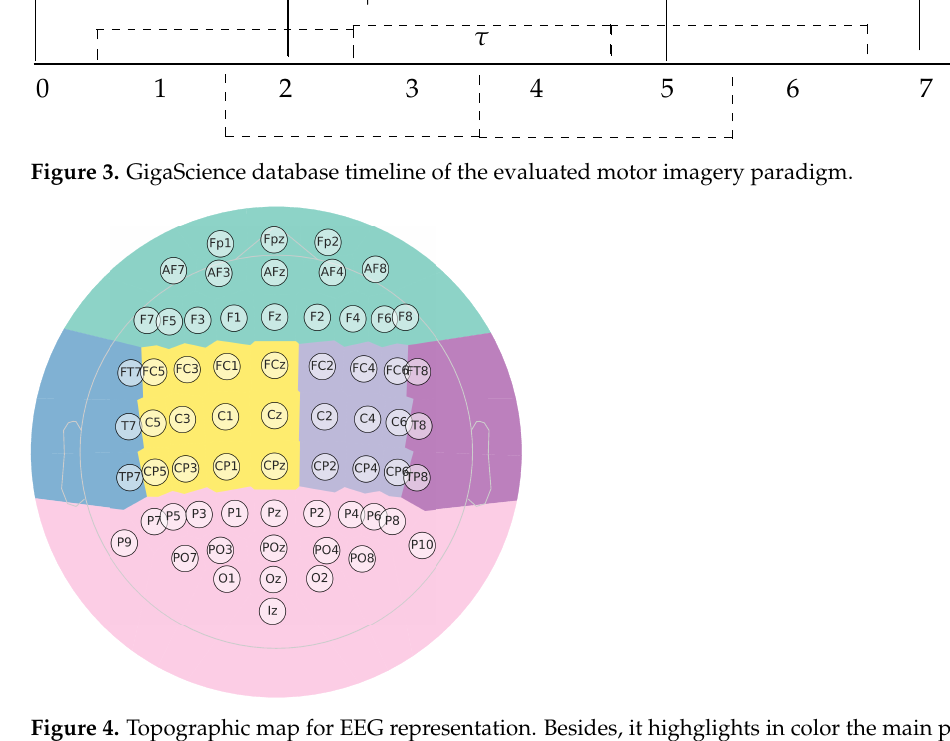
Figure 4. Topographic map for EEG representation. Besides, it highglights in color the main parts of the brain (Frontal, Central right, Posterior right, Posterior, Posterior left, Central